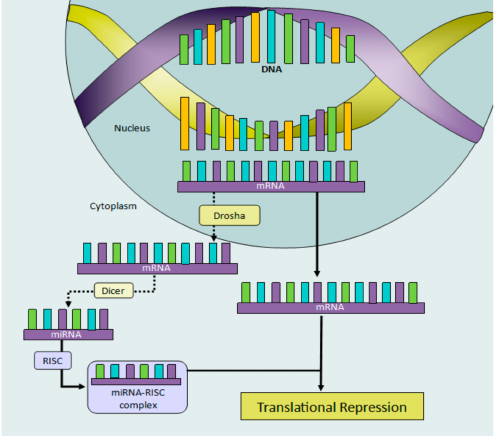
Figure 3. miRNA translational repression: to block protein expression, miRNA target mRNA and bind to them, preventing translation. Inside the nucleus, primary miRNA are cleaved by RNase III Drosha to produce smaller precursors of 60–70 nucleotides, which then translocate to the cytoplasm. Once there, the precursors are processed by another RNase III Dicer, which generates a duplex RNA of ~22 nucleotides. One strand is degraded, and the other is incorporated into the RNA-induced silencing complex (RISC), where it binds to the 3 (cid:48) untranslated region of complementary mRNA. As a consequence, this may result either in its degradation and/or reduced translation, which has been proposed to lead to translational repression. Figure by Gabriela Olivares-Castro